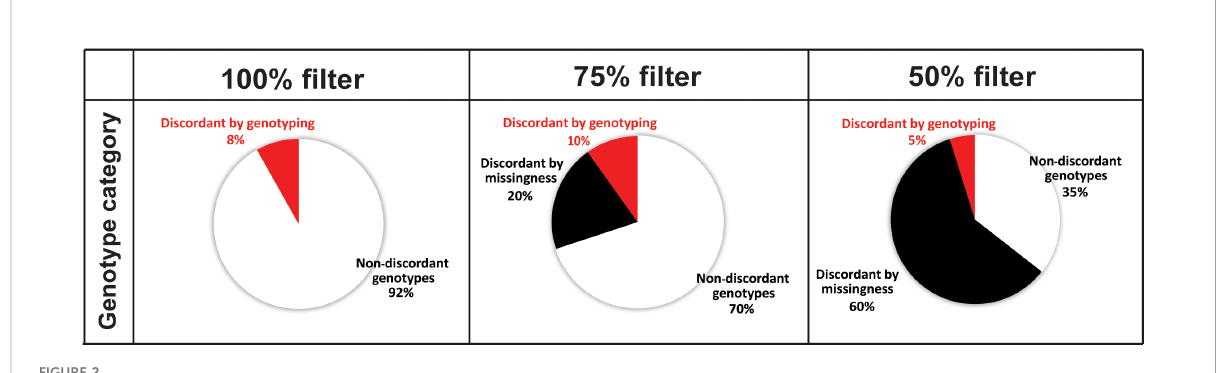
FIGURE 2 Mean percentage of loci of each genotype category when comparing the two library types for each individual in the NN-WN dataset. ‘ Discordant by missingness ’ are those loci without genotype for one of the libraries, ‘ discordant by genotyping ’ when both genotypes have information but do not agree, and ‘ non-discordant ’ when the loci display the same genotype. Each fi ltered fi le (100%, 75% and 50%) has been considered separately.